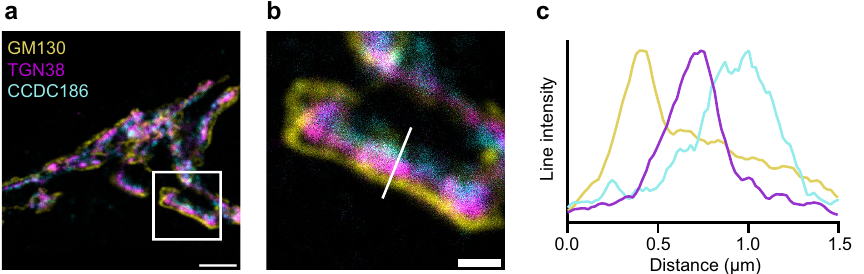
Figure 1. Golgi stacks visualized using confocal microscopy. ( a ) Neuron stained for GM130 ( cis -Golgi), TGN38 (TGN) and CCDC186. ( b ) Zoom from the white square area marked in ( a ). ( c ) Line intensity profile along white line in ( b ). Intensities were normalized and smoothed before plotting. Scale bar is 3 µm ( a ) and 1 µm ( b